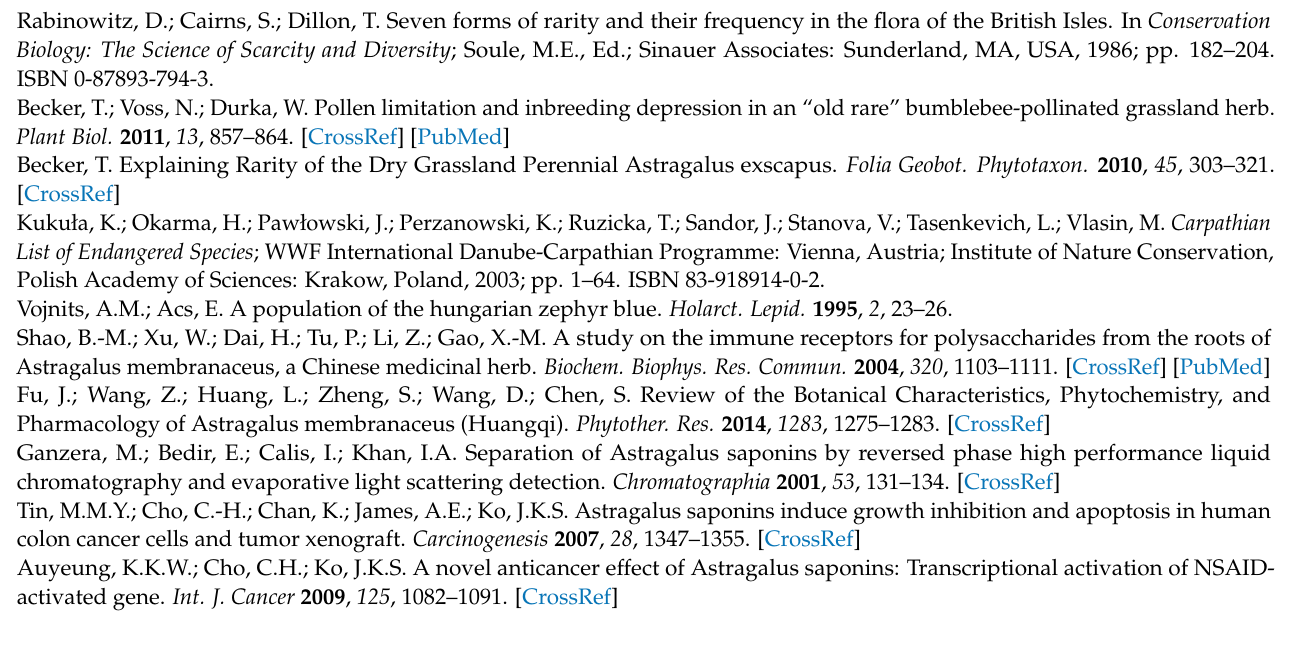
Supplementary Materials: The following are available online at https://www.mdpi.com/article/ 10.3390/plants10122732/s1: Figure S1. Electrophoretic profiles of individuals from the eight studied populations, generated by the SRAP primer combination Me4/Em5; Figure S2. Graphical representa- tion of population structure using STRUCTURE 2.3.4. software and Harvester v. 6.0 online program. (a) Evanno table output; (b) the median and variance of the estimated probability value for each K value; Table S1. Jaccard’s similarity coefficient among 125 individuals from eight populations of A. exscapus subsp. transsilvanicus based on SRAP data